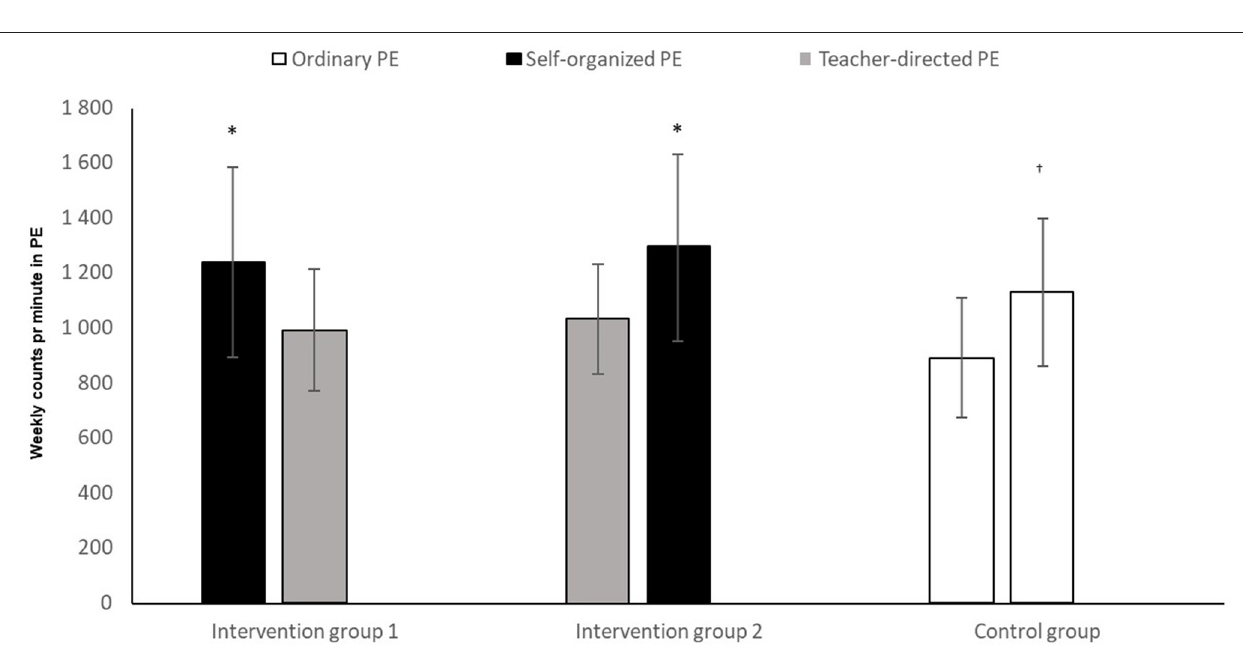
FIGURE 8 | Number of counts per minute among pupils in two time periods of ordinary PE, teacher-directed PE, and self-determined PE. *Significantly higher number of counts per minute with self-determination, compared to teacher-directed instruction ( p < 0.05). † Significantly higher number of counts per minute in T2, compared to T1 ( p <